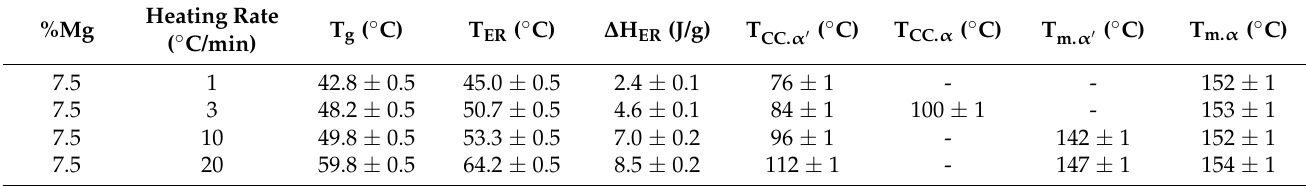
Table 2. Thermal properties of the extruded 1D PLA and PLA-Mg filaments. T g : glass transition; T ER